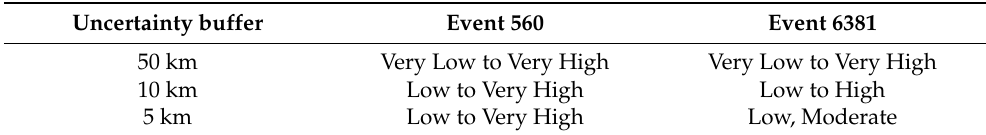
Figure 5. “Original” susceptibility model highlighting numerous susceptibility classifications within 5 to 50 km buffers for events 560 and 6381. Table 7. “Original” susceptibility results for events 560 and 6381, within location uncertainty buffers from 5 to 50 km.